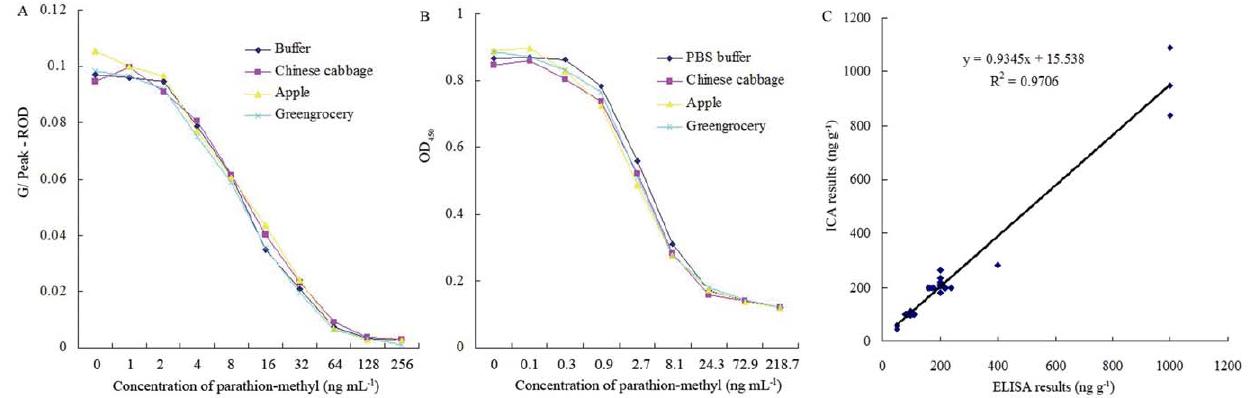
Figure 6. Matrix interference study and correlation of recoveries between the ICA and ELISA. A: Standard inhibition curves for parathion- methyl in the buffer and different matrices using the multi-analyte ICA, Chinese cabbage and Apple samples were diluted 5-fold, and greengrocery samples were diluted 20-fold; B: Standard inhibition curves for parathion-methyl in the buffer and different matrices using the multi-analyte ELISA, Chinese cabbage, Apple and greengrocery samples were diluted 40-fold; C: The degree of correlation between the multi-analyte ICA and ELISA for analyses of samples spiked with parathion-methyl, parathion, and fenitrothion. doi:10.1371/journal.pone.0053099.g006 PLOS ONE |